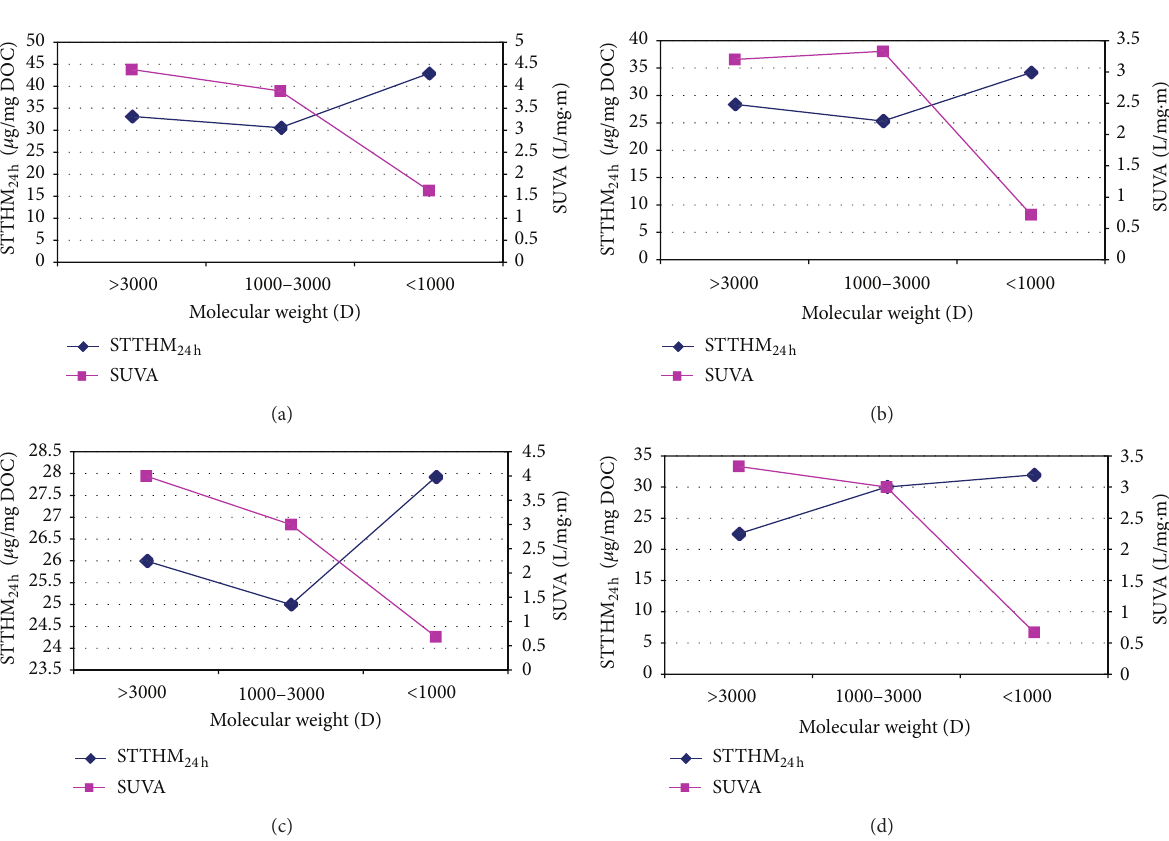
ofphysicalfractionsintheNOMfor(a)rawwater,(b)ozonationprocess,(c)coagulation- h